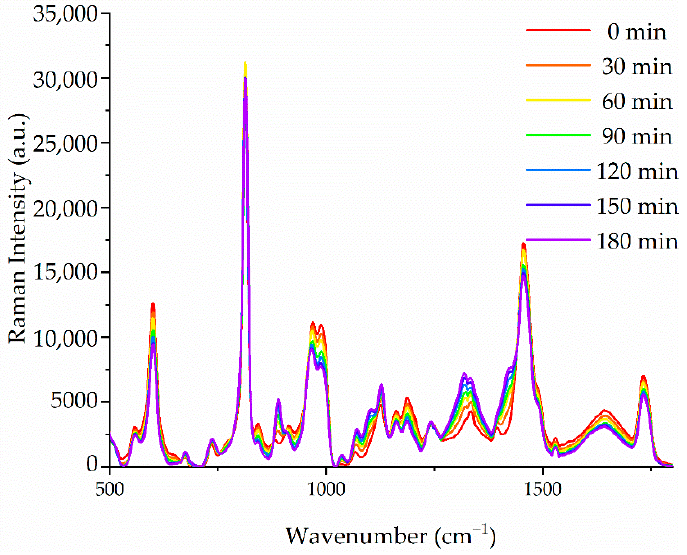
Figure 3. Raman spectra progression of the hydrogel formation for an acquisition period of 3 h.